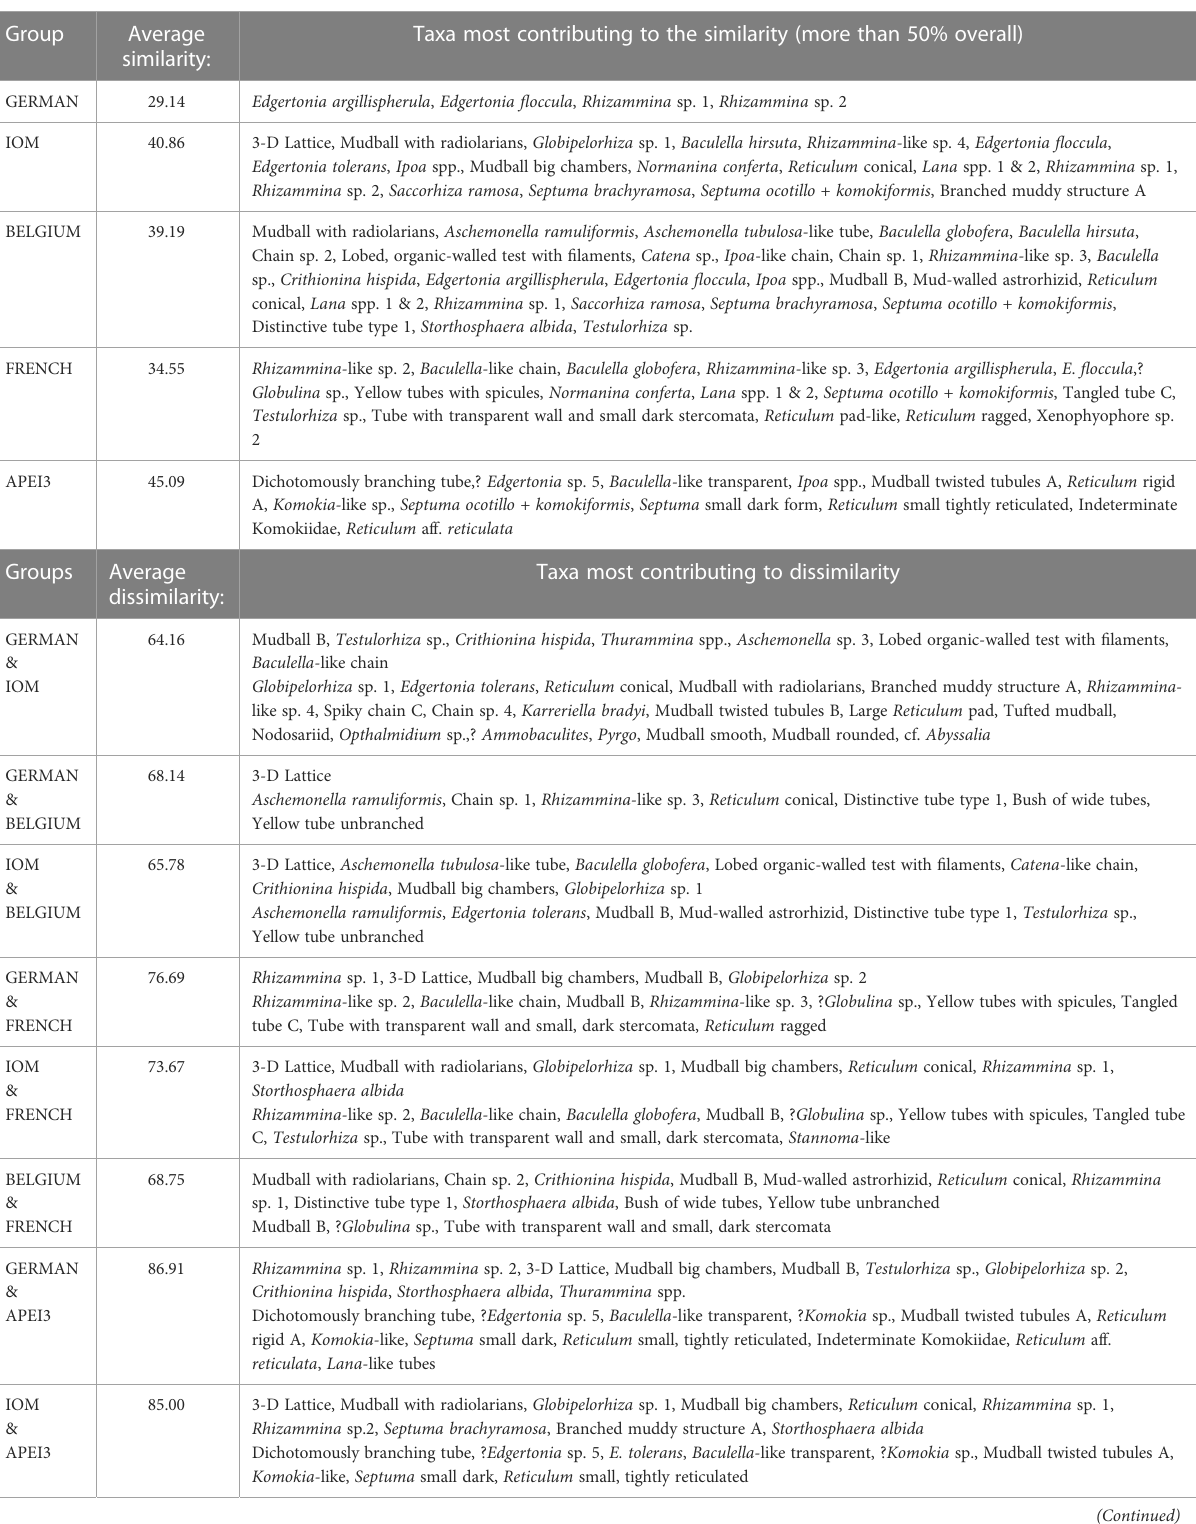
TABLE 6 Results of the SIMPER analysis for the similarity/dissimilarity of the taxonomic structure (presence/absence of species) of macrofauna- sized foraminifera based on complete specimens and fragments combined. Group Average Taxa most contributing to the similarity (more than 50% overall) similarity: GERMAN 29.14